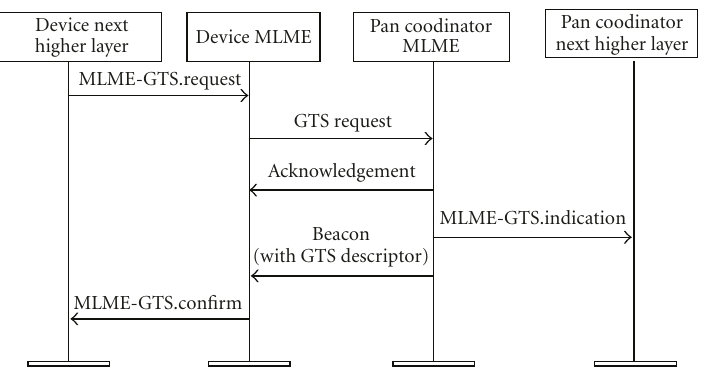
Figure 18: Sequence diagram for a GTS allocation request by a device